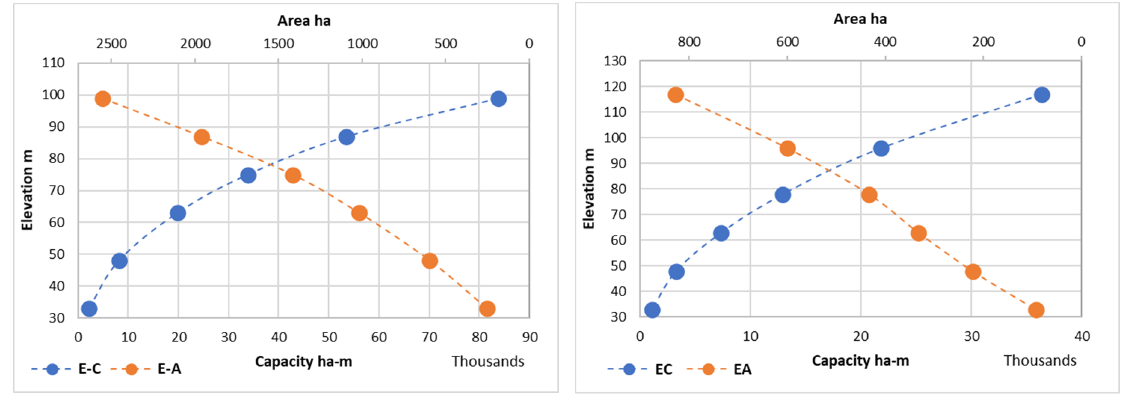
Figure 6. EAC curve for Dam-A (left) and Dam-B (Right).